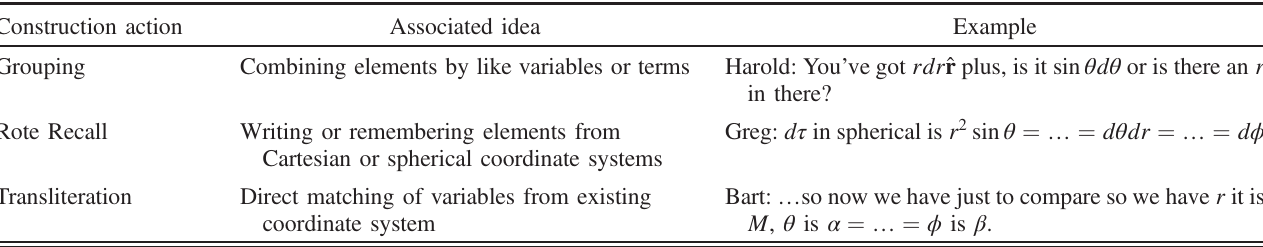
TABLE II. Actions taken by students during construction of a differential length vector for schmerical coordinates [18]. Construction